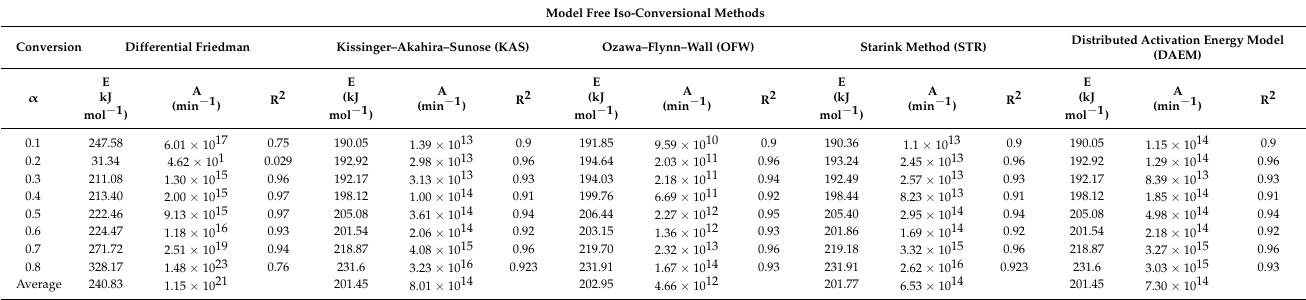
Table 4. Activation Energy and the pre-exponential factors for PET plastic.